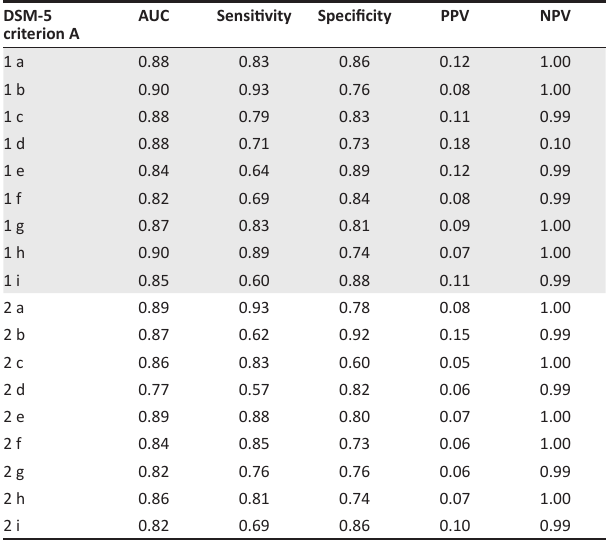
TABLE 1: Item characteristics. DSM-5 AUC Sensitivity criterion A